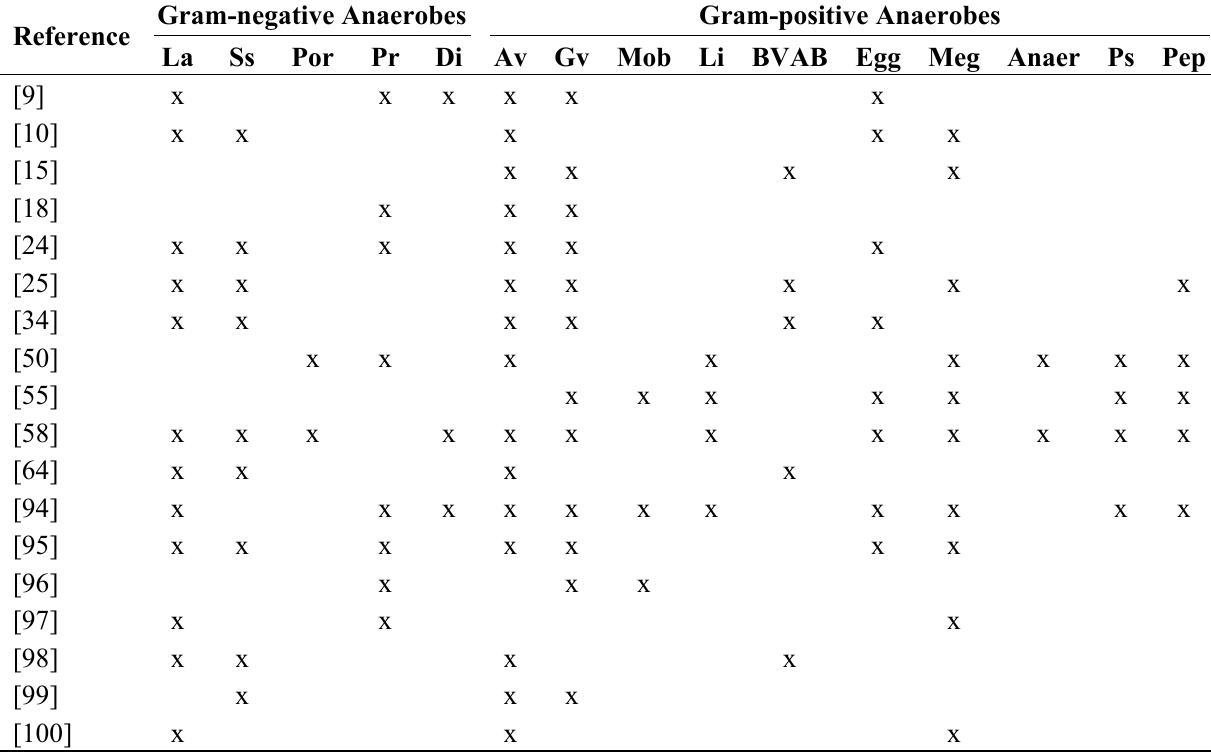
Table 1. Anaerobic microbial consortia most frequently associated with bacterial vaginosis and preterm